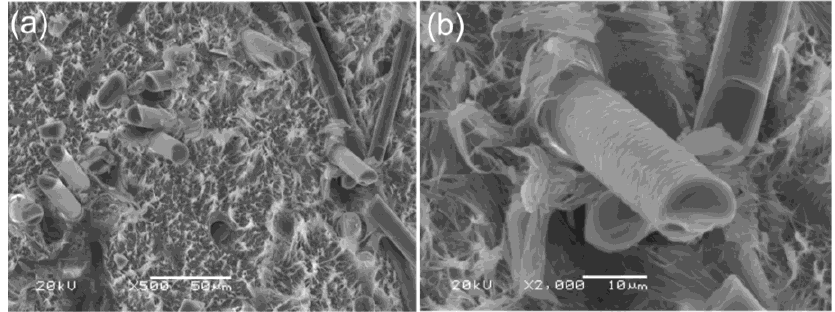
Figure 2. SEM images of bio-polyethylene with basalt fibers ( a ) 500× and ( b ) 2000× magnification.